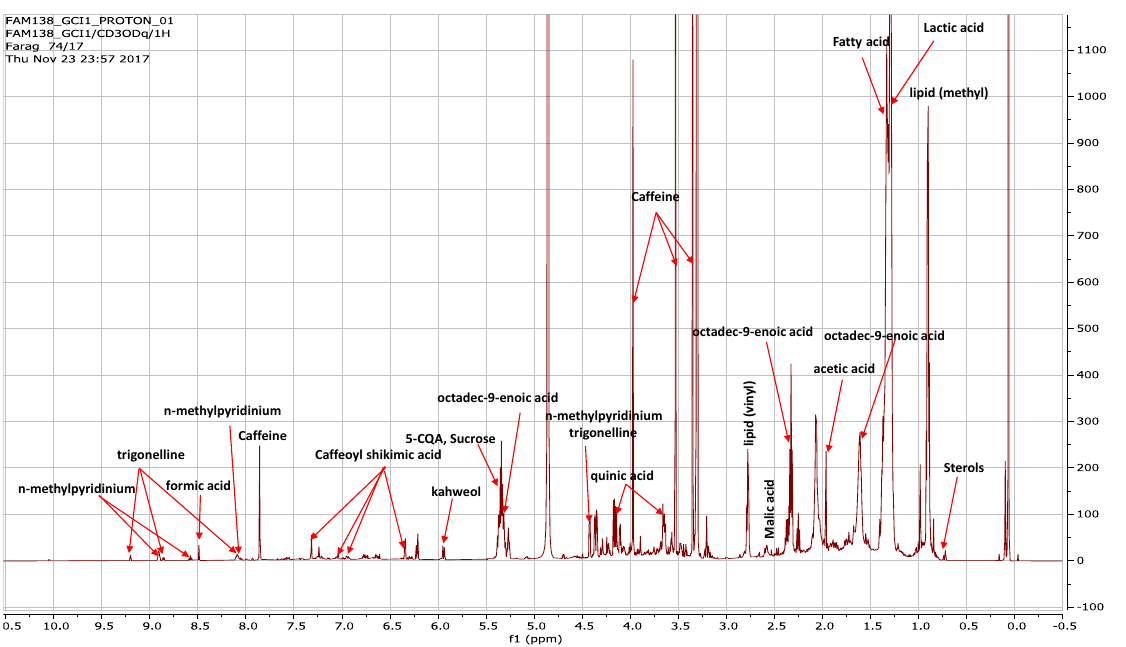
Figure 2. Representative 1 H NMR spectrum ( δ H : 0 – 10 ppm) of the Luwak coffee sample in CD 3 OD. Kahweol is a diterpene that is reported as a marker of C. arabica , identified based on its two key doublet signals at δ H 5.9 ppm (due to H-2), δ H 6.2 ppm (due to H-1 and H-18), and δ H 7.2 ppm (due to H-1 and H-19) [19]. The characterization of its signals verified